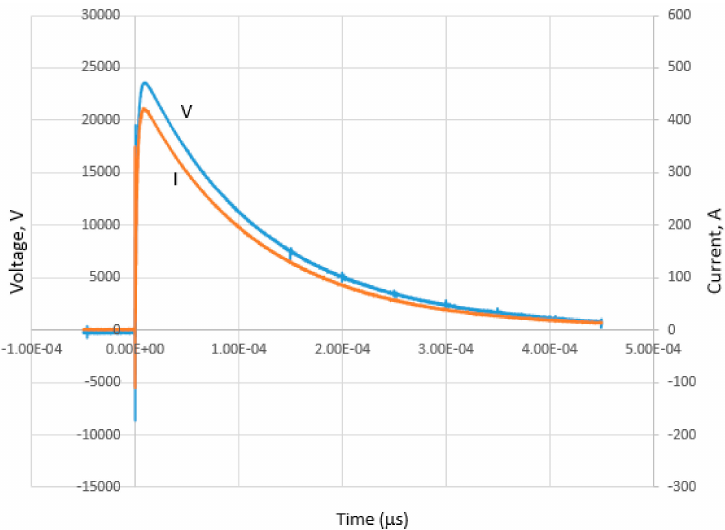
Figure 22. Voltage and current traces of 3-rod electrodes, at a charging voltage of 30 kV.